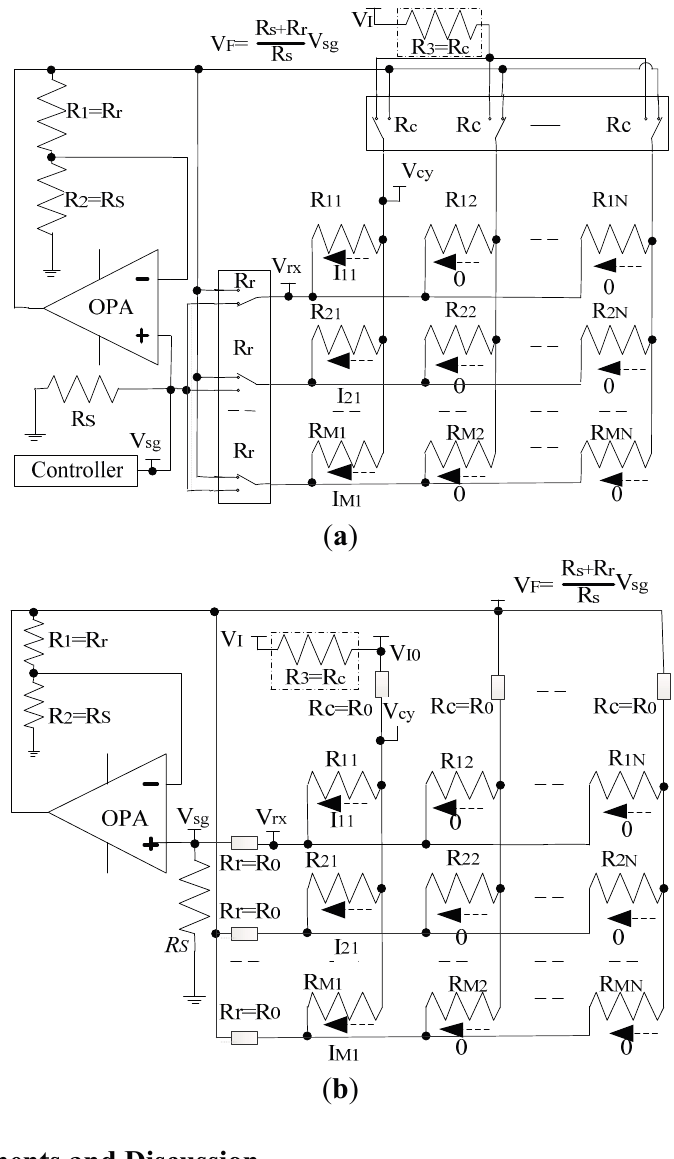
Figure 1. ( a ) Improved Isolated Drive Feedback Circuit with Compensation